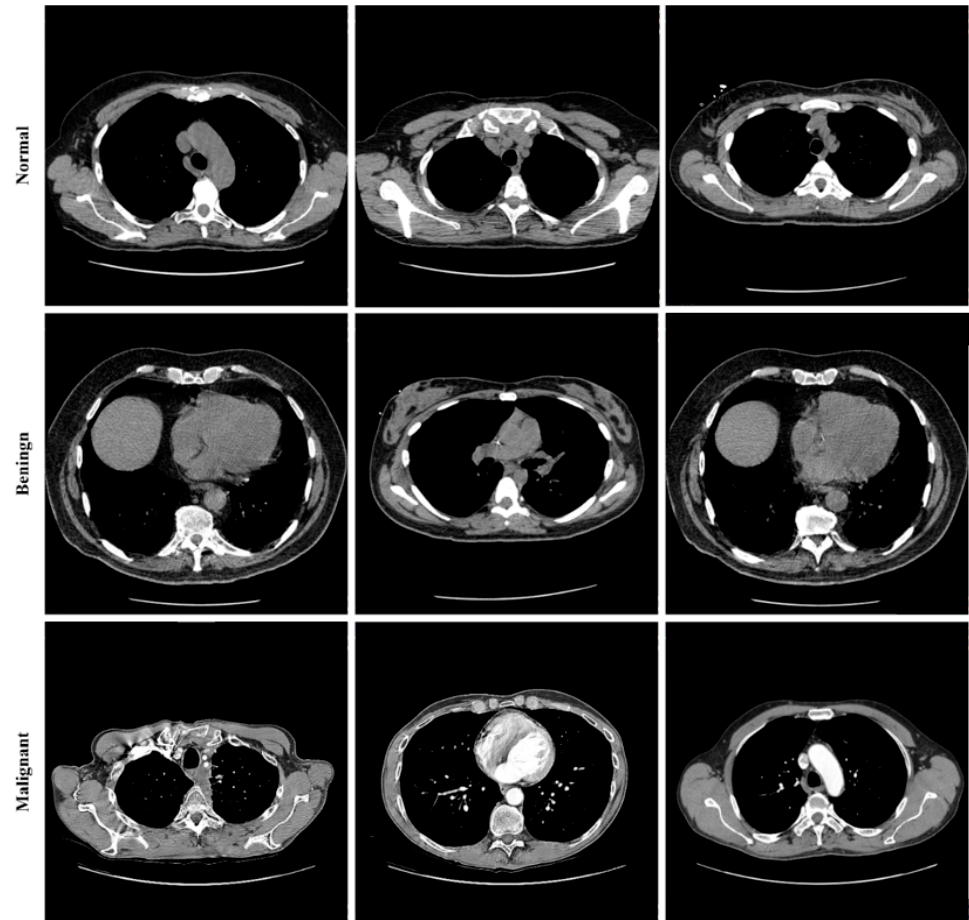
Figure 8. Sample images from the LIDC-IDRI dataset.